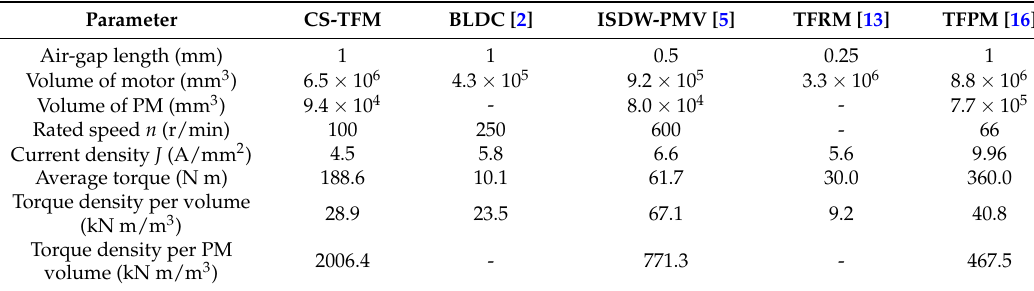
Table 3. Comparison of torque